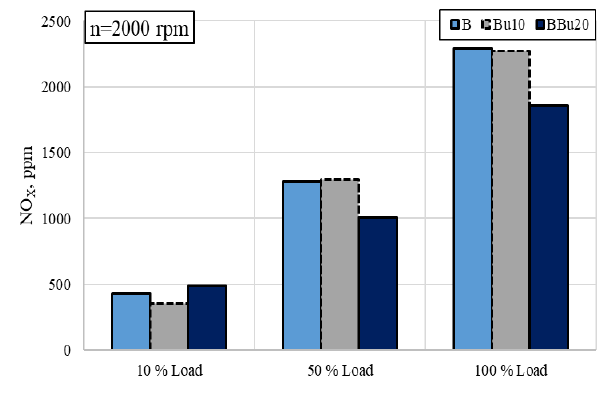
Fig. 4. The total nitrogen oxide (NO x ) emissions as a function of engine load when running at maximum torque speed of 2000